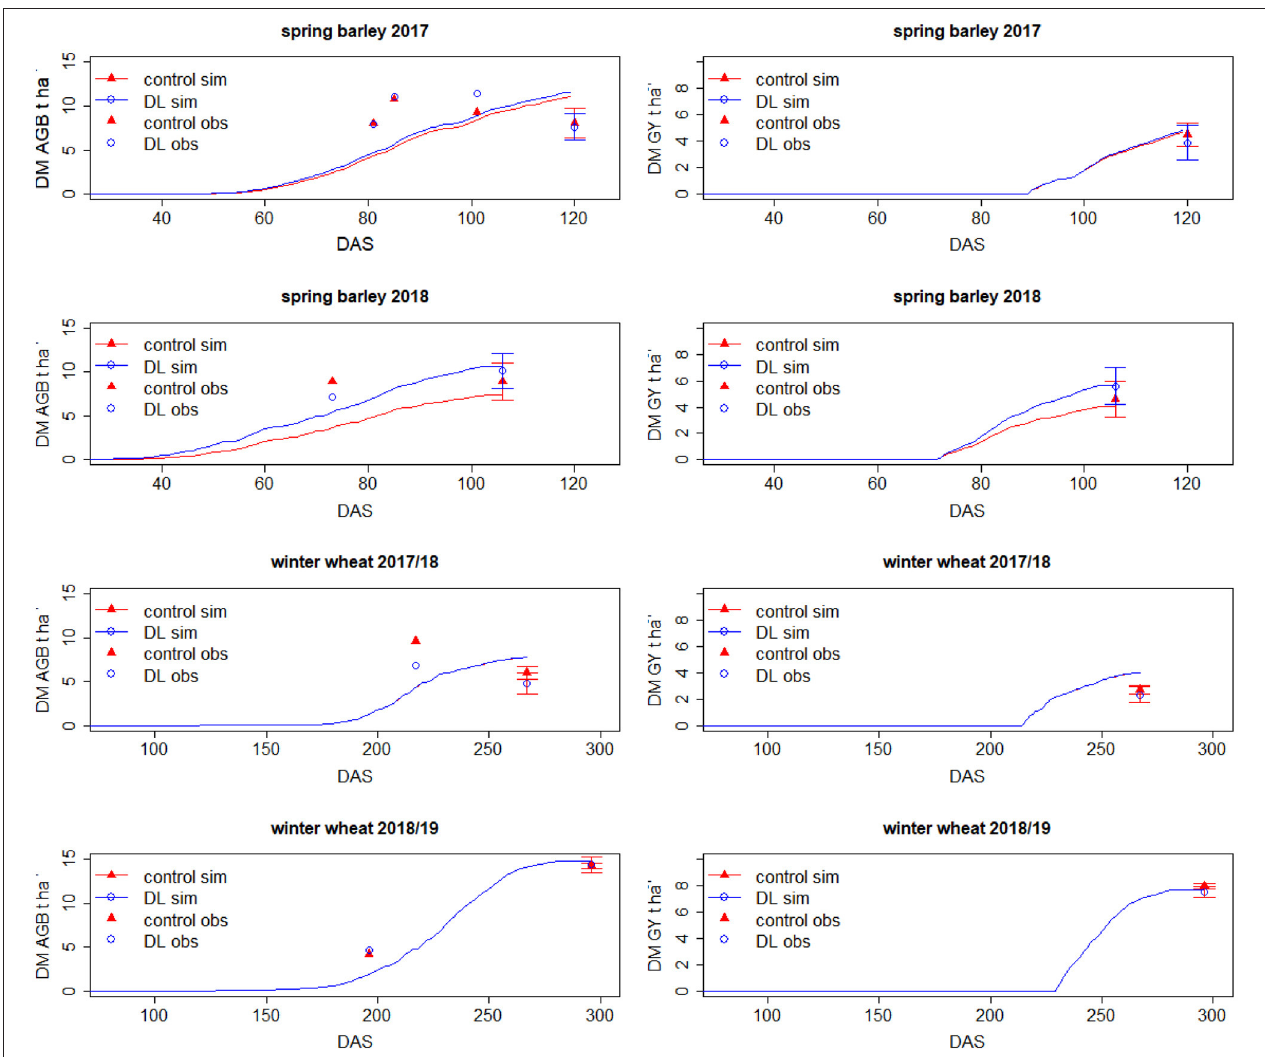
FIGURE 2 | Observed (dots and triangles) and simulated (lines, applying SIMPLACE-CRootbox model) dry matter above-ground biomass during the growth season and at harvest (DM AGB) and grain yield (DM GY) in t ha − 1 of spring barley (2017 and 2018) and winter wheat (2017/18 and 2018/19) for the control and DL (at strip) treatments. The observed yield data at harvest are given as mean values with standard